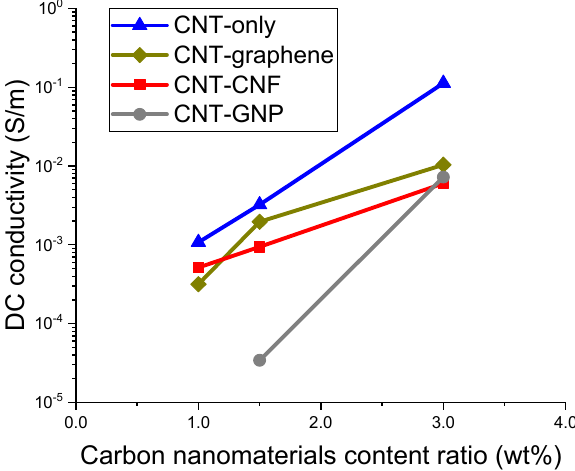
Figure 4. Electrical conductivity of the epoxy-based composites incorporating CNT-only, CNT– graphene, CNT–CNF, or CNT–GNP, determined by means of two-probe method and plotted as a function of CNM content